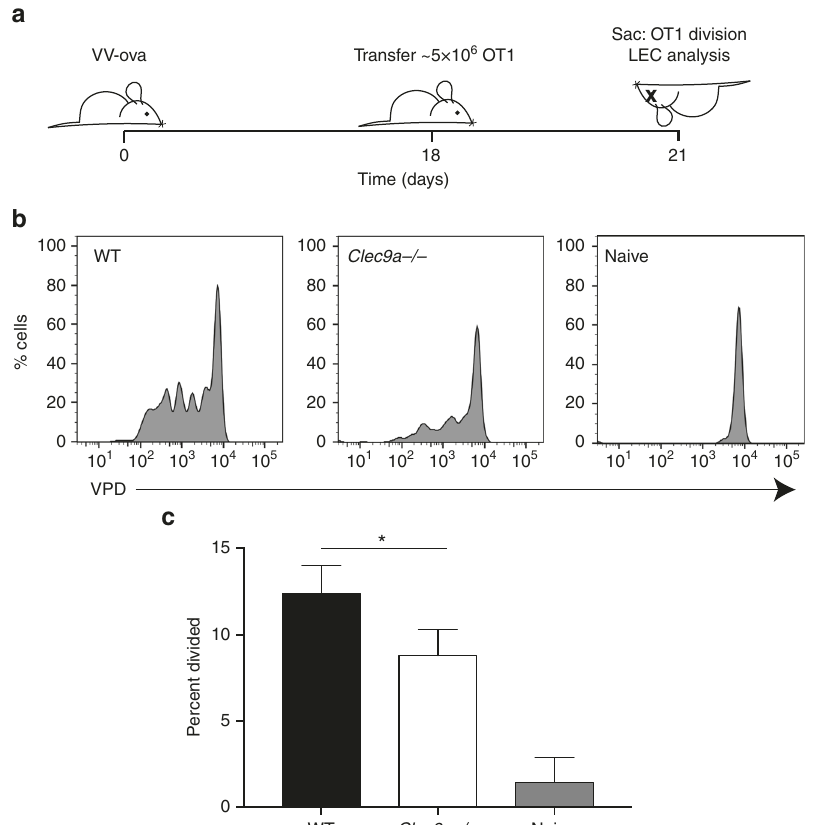
Fig. 9 Antigen exchange following vaccinia infection utilizes Clec9a. a Schematic of experimental design. b WT and Clec9a − / − mice were infected with vaccinia-ova and 2 weeks later violet proliferation dye (VPD)-labeled OT1 T cells were transferred. OT1 division was evaluated. c Quanti fi cation of the percent divided in the groups shown in b , where mice of each genotype were pooled from two independent experiments of three mice each. Statistical analysis was done using an unpaired t -test where the p -value between wild-type and Clec9a − / − is 0.0305. Error bars are mean ± standard error of the